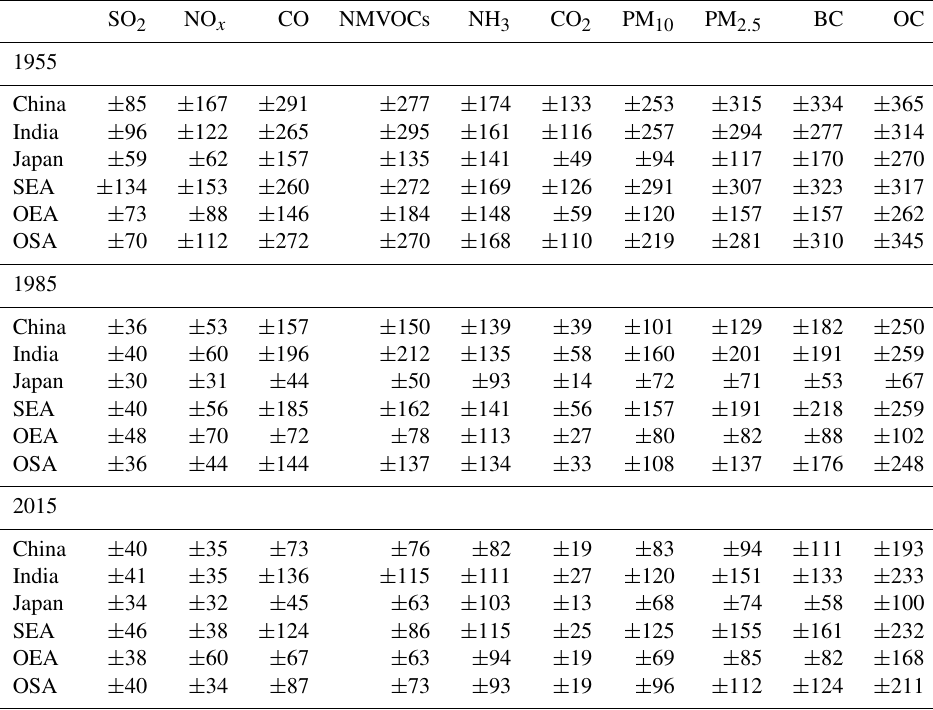
Table 4. Uncertainties [%] of emissions in China, India, Japan, SEA, OEA, and OSA in 1955, 1985, and 2015. See Fig. 1 for definitions of SEA OEA, and